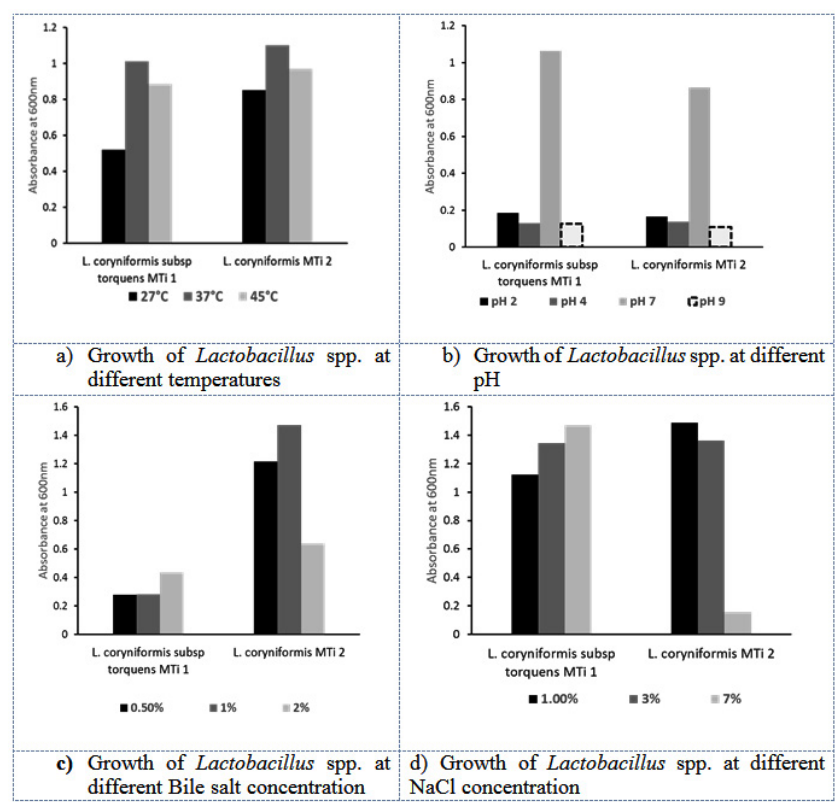
Fig. 2. (a-d). Both L. coryniformis subsp. torquens MTi1 and L. coryniformis MTi2 could withstand at wide range of temperatures(27-45°C), pH (2-9), bile salt concentration (0.5-2%) and NaCl (1-7%)